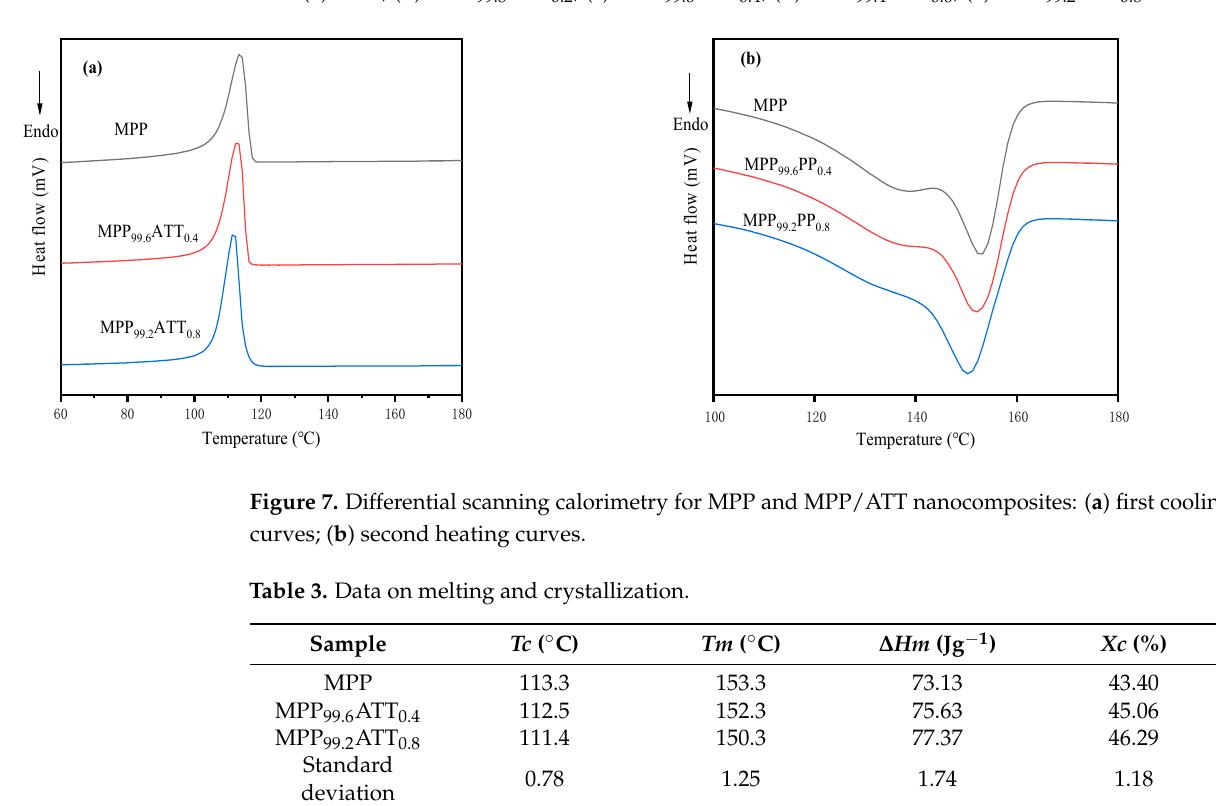
Figure 6. Surface SEM micrographs of fractured MPP/ATT nanocomposites with various amounts of ATT: ( a ) MPP; ( b ) MPP 99.8 ATT 0.2 ; ( c ) MPP 99.6 ATT 0.4 ; ( d ) MPP 99.4 ATT 0.6 ; ( e ) MPP 99.2 ATT 0.8 .